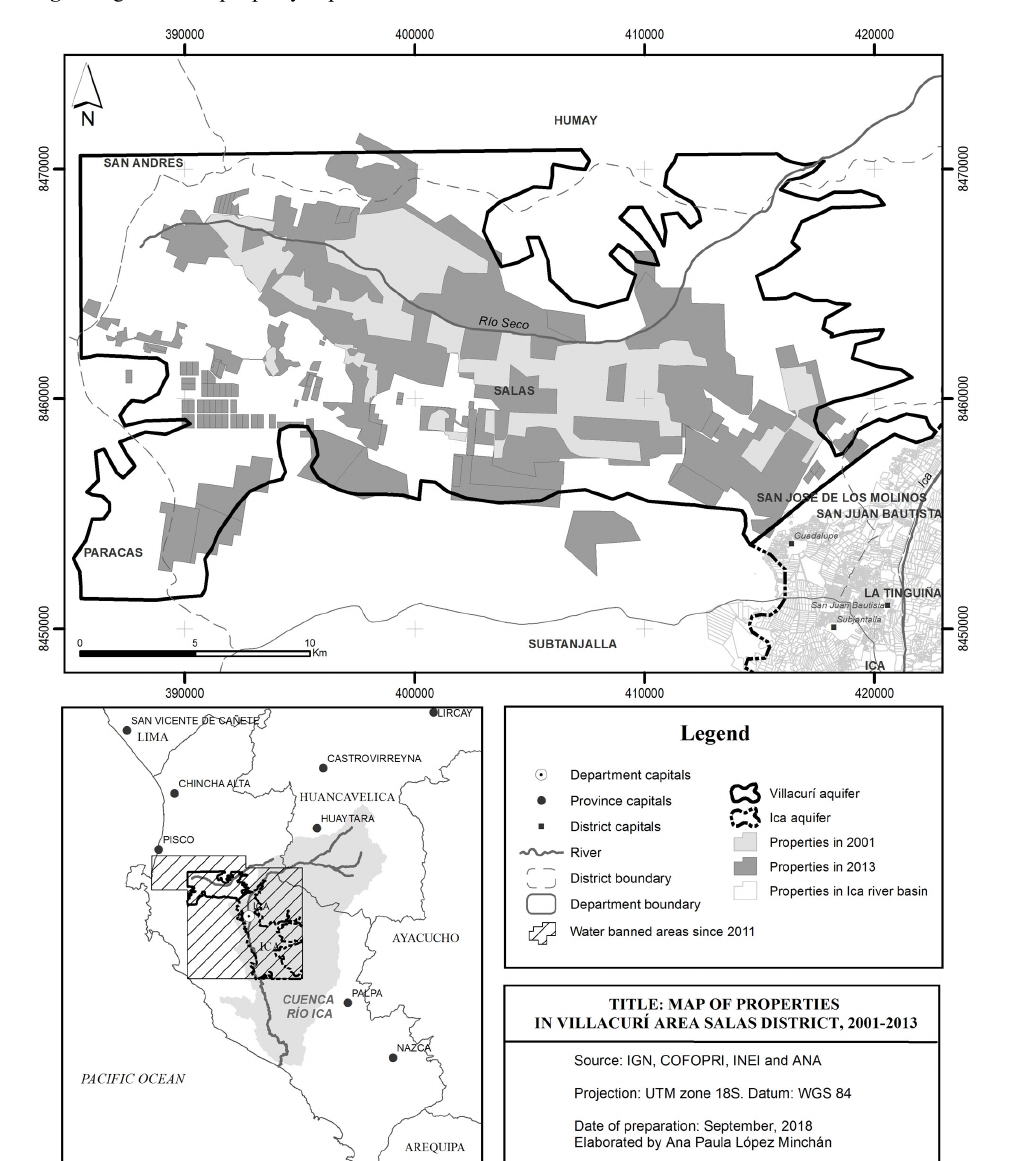
Fig. 1 . Agricultural property expansion between 2011 and 2013 in